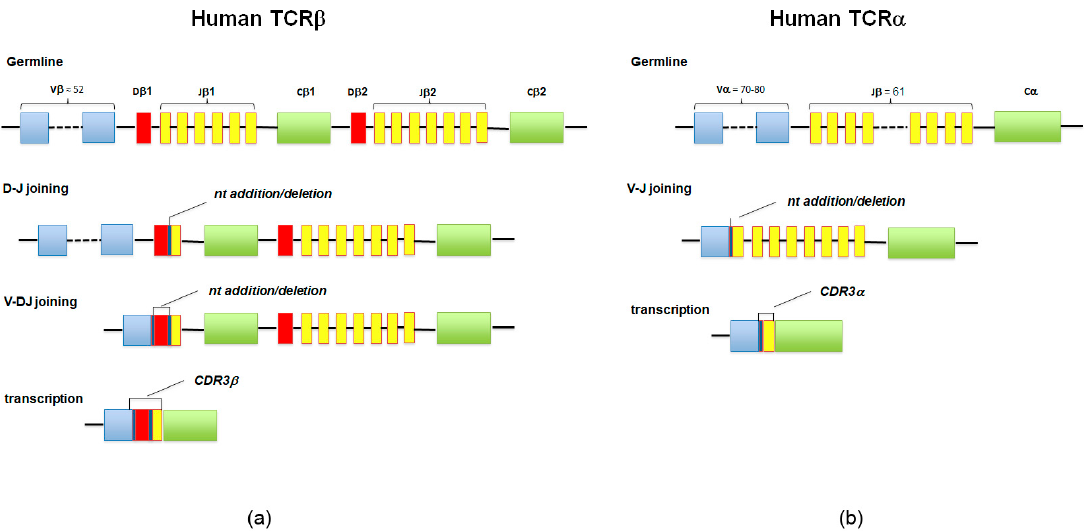
Figure 2. ( a , b ) The diversity of T-cell receptor (TCR) αβ is a result of genetic recombination and diversification mechanisms occurring at the α and β TCR chain loci. Diversity is first created in the germline via recombination of variable V, diversity D (for β chain), and joining J segments. Further diversification occurs through imprecise junctions of these gene segments (addition of P- and N-nucleotides adjacent to the D segment), and the combination of α and β chains.